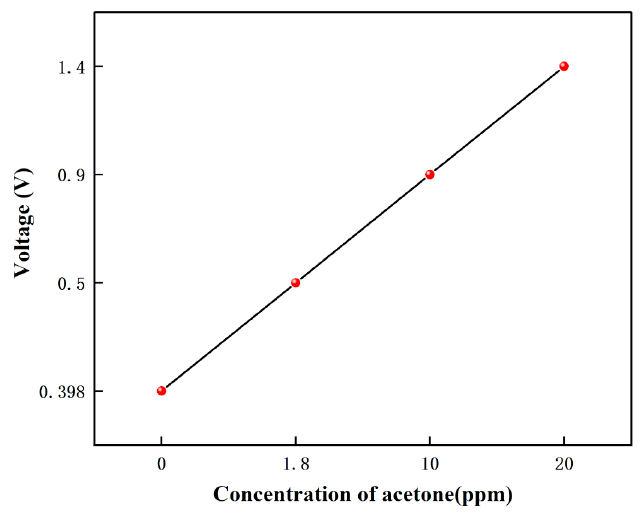
Figure 18. The voltage response graph for different concentrations of